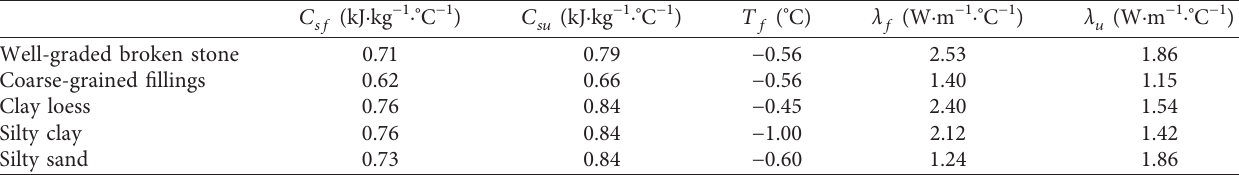
Table 1: Thermal characteristic parameters of soil.